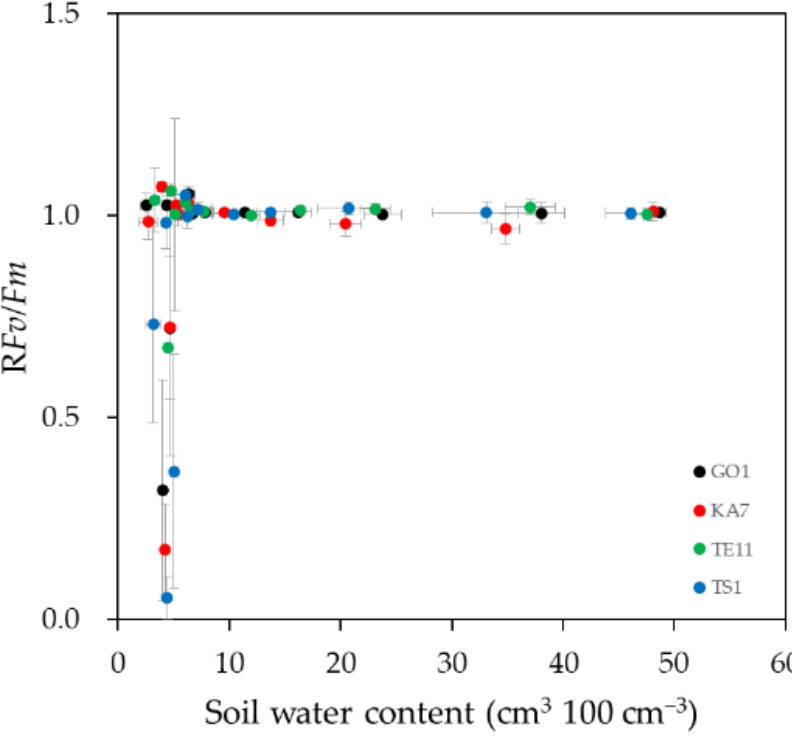
Figure 7. Relationship between the soil water content and R Fv / Fm . The black, red, green, and blue symbols correspond to the clones GO1, KA7, TE11, and TS1, respectively.